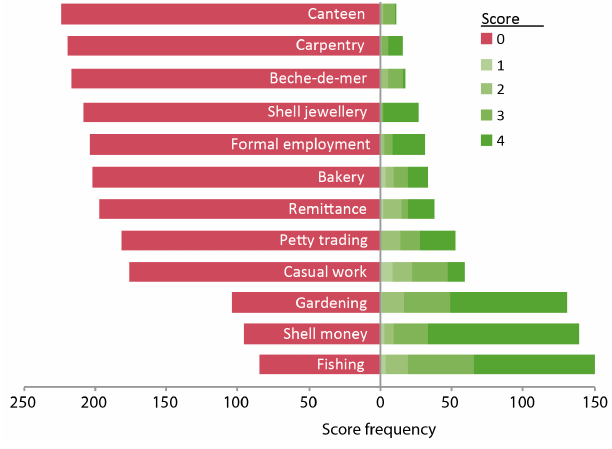
Fig. 5 . Frequency distribution of livelihood scoring by 235 households for the 12 most common activities in Langalanga Lagoon in 2013 (0 = not important, 1 = somewhat important, 2 = quite important, 3 = important, 4 = very